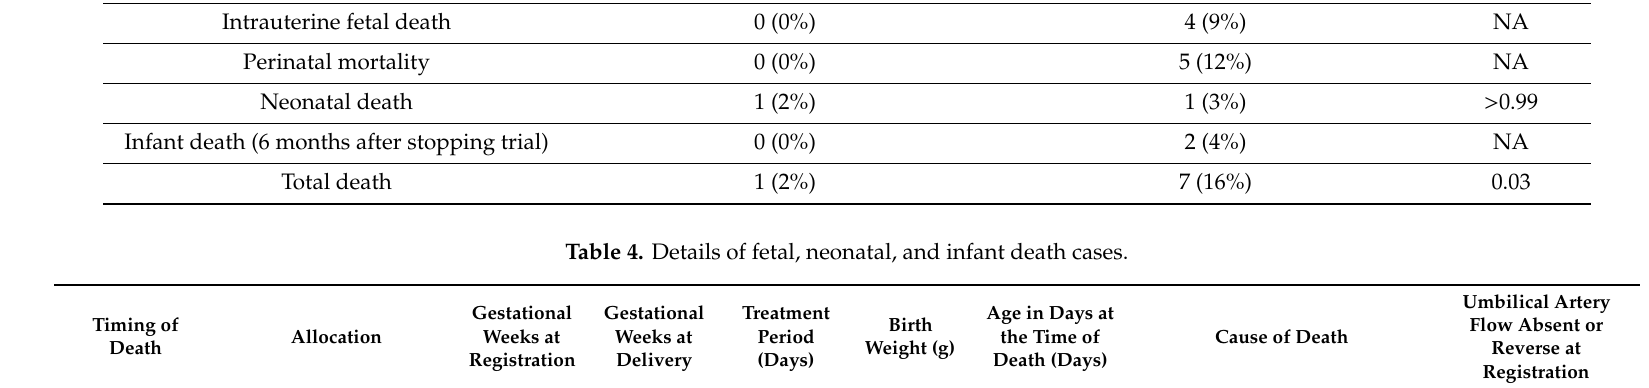
Table 3. Fetal, neonatal, and infant deaths. Data are presented as n (%); NA: not available. Tadalafil Treatment Group ( n = 44)